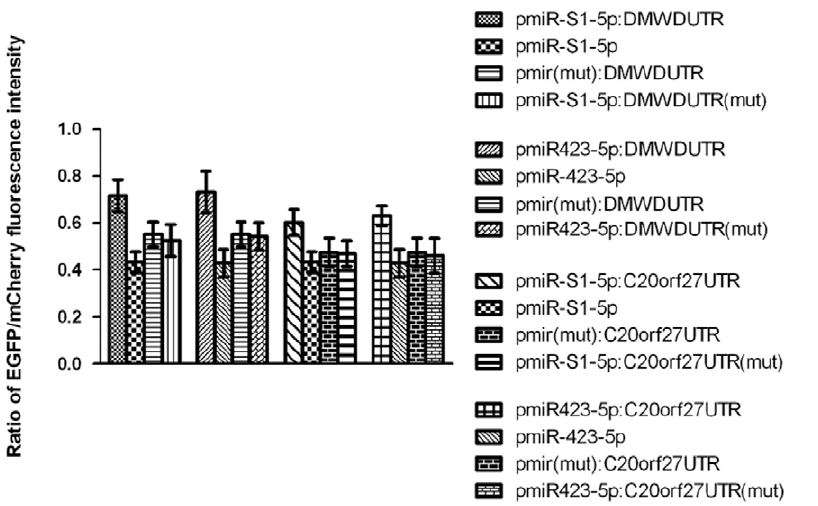
Figure 5. sv40-miR-S1-5p and hsa-miR423-5p downregulate the predicted biological targets of hsa-miR423-5p. HeLa cultures were transfected by the indicator vectors pmiR-S1-5p:DMWDUTR, pmiR423-5p:DMWDUTR, pmiR-S1-5p:C20orf27UTR, pmiR423-5p:C20orf27UTR and their control vectors with miRNAs only, with miRNA deletions or without miRNA pairing sites in the 3 9 -UTR.